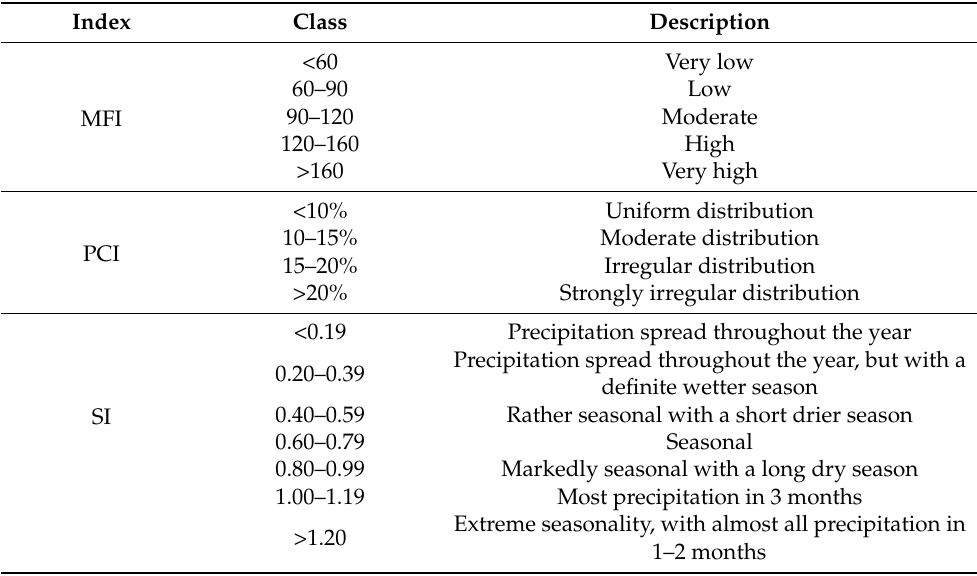
Table 1. Classification of MFI, PCI, and SI